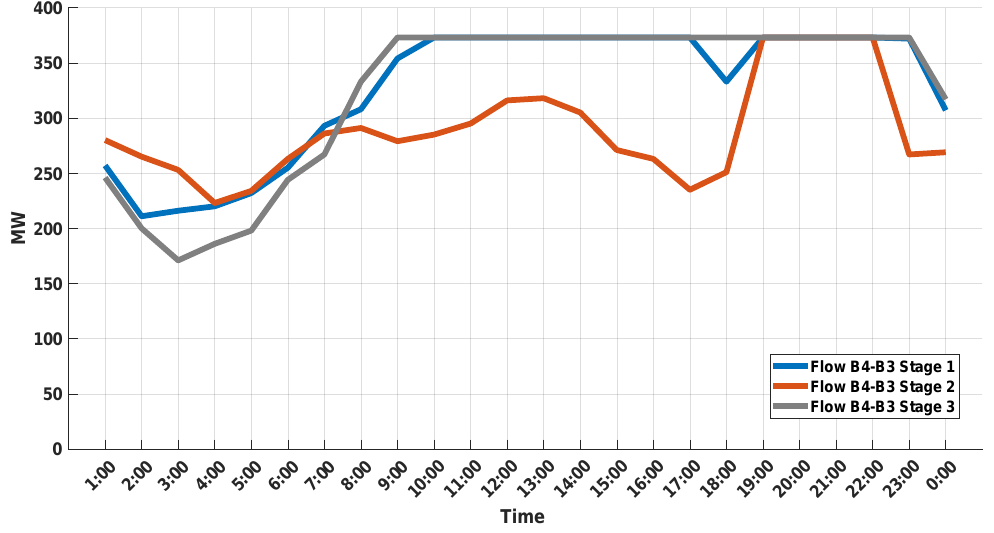
Figure 30. Power flow variation from bus 4 to bus 3